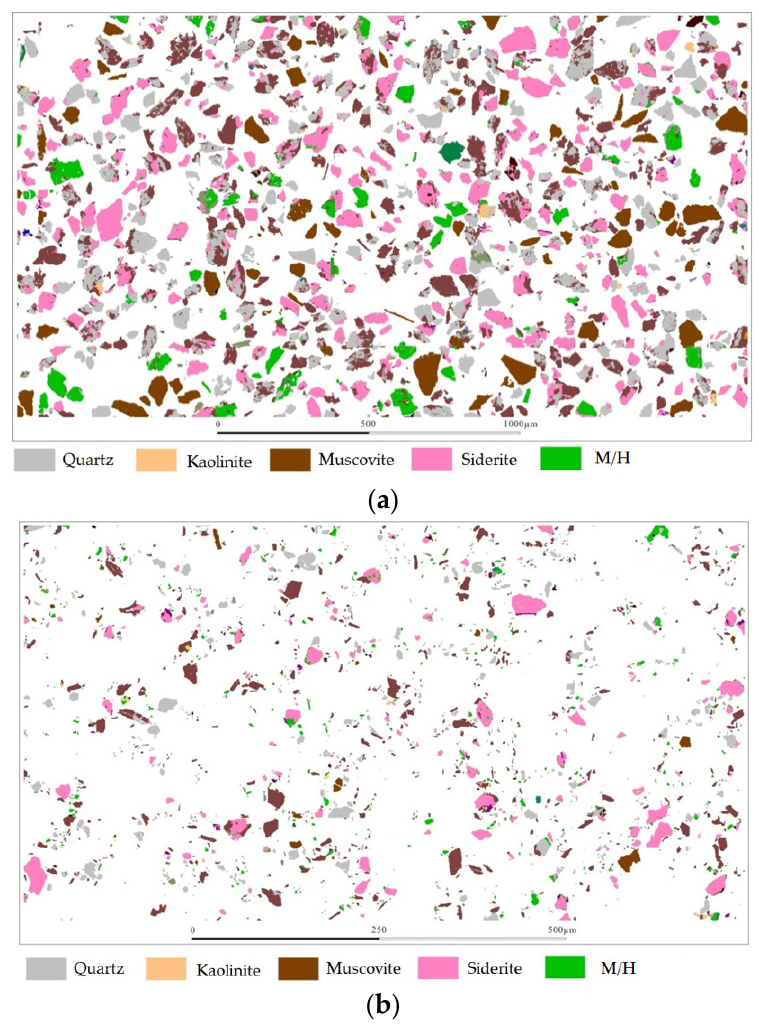
Figure 7. The mineral map of the tailing. ( a ) the particle size of − 38~ +75 μ m and ( b ) particle size of − 38 μ m.